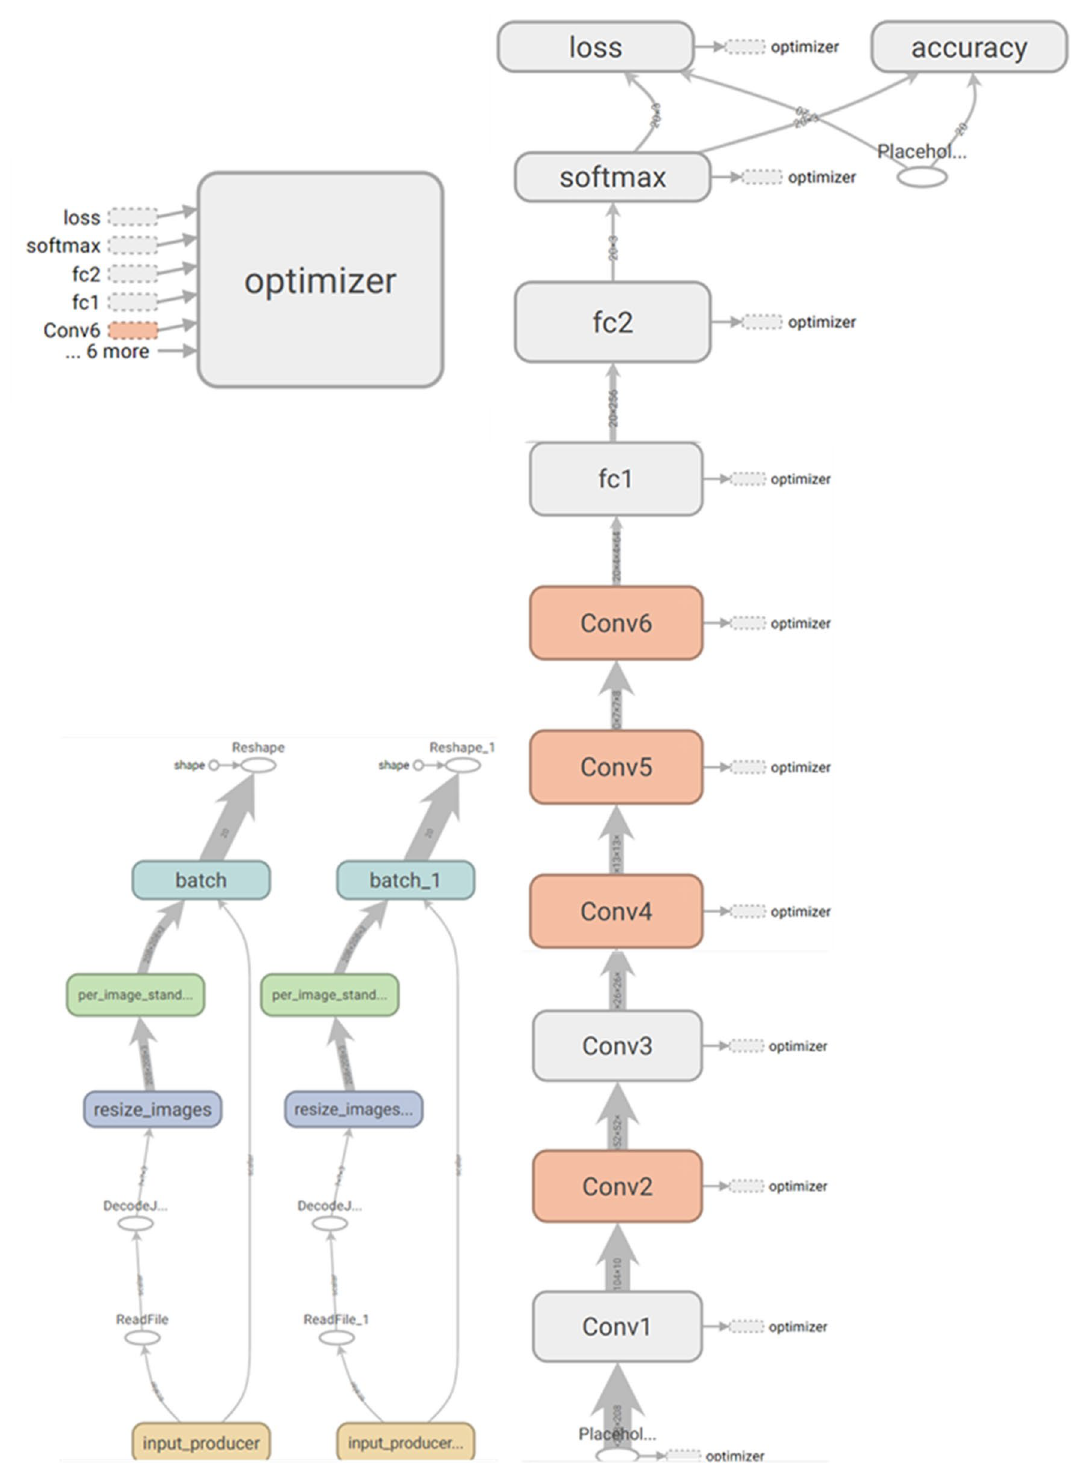
Figure 8. Visual architecture of the proposed